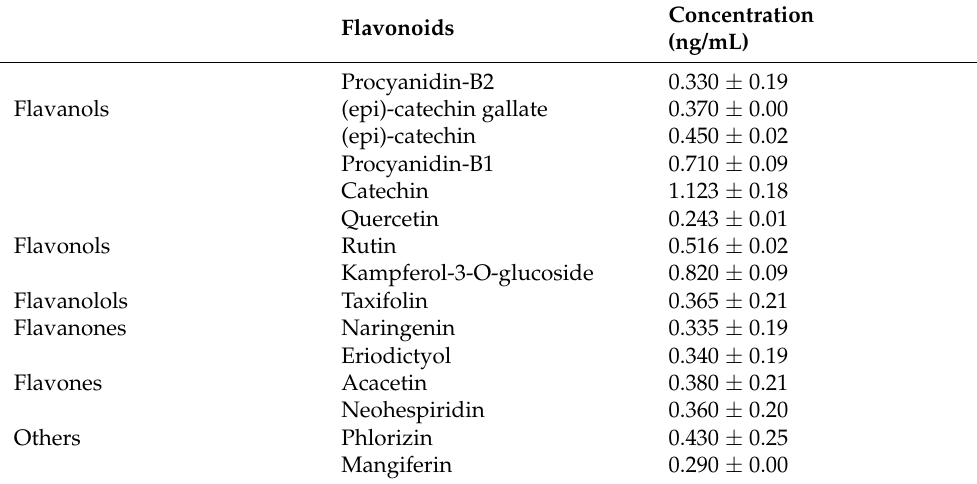
Table 1. Polyphenol characterization of aqueous extracts of Quercus resinosa leaves.